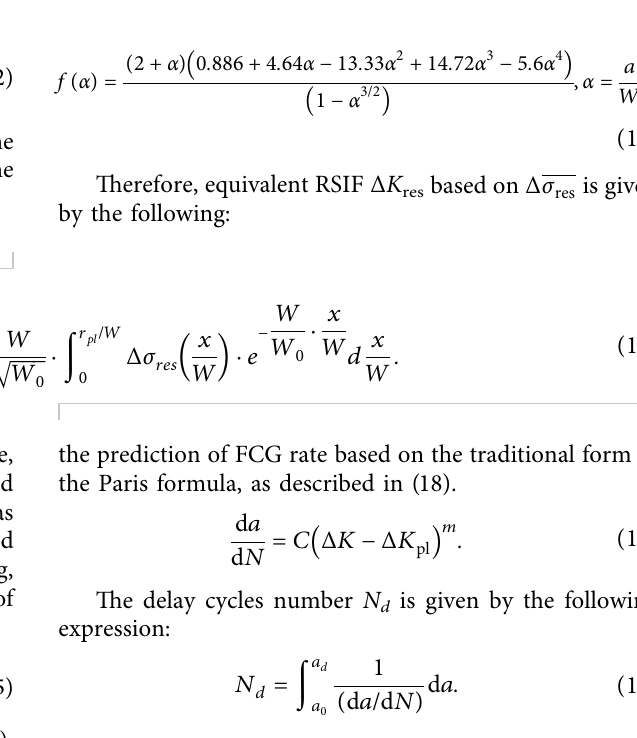
Figure 3: Superposed residual stress distribution considering elastoplastic hardening in plastic